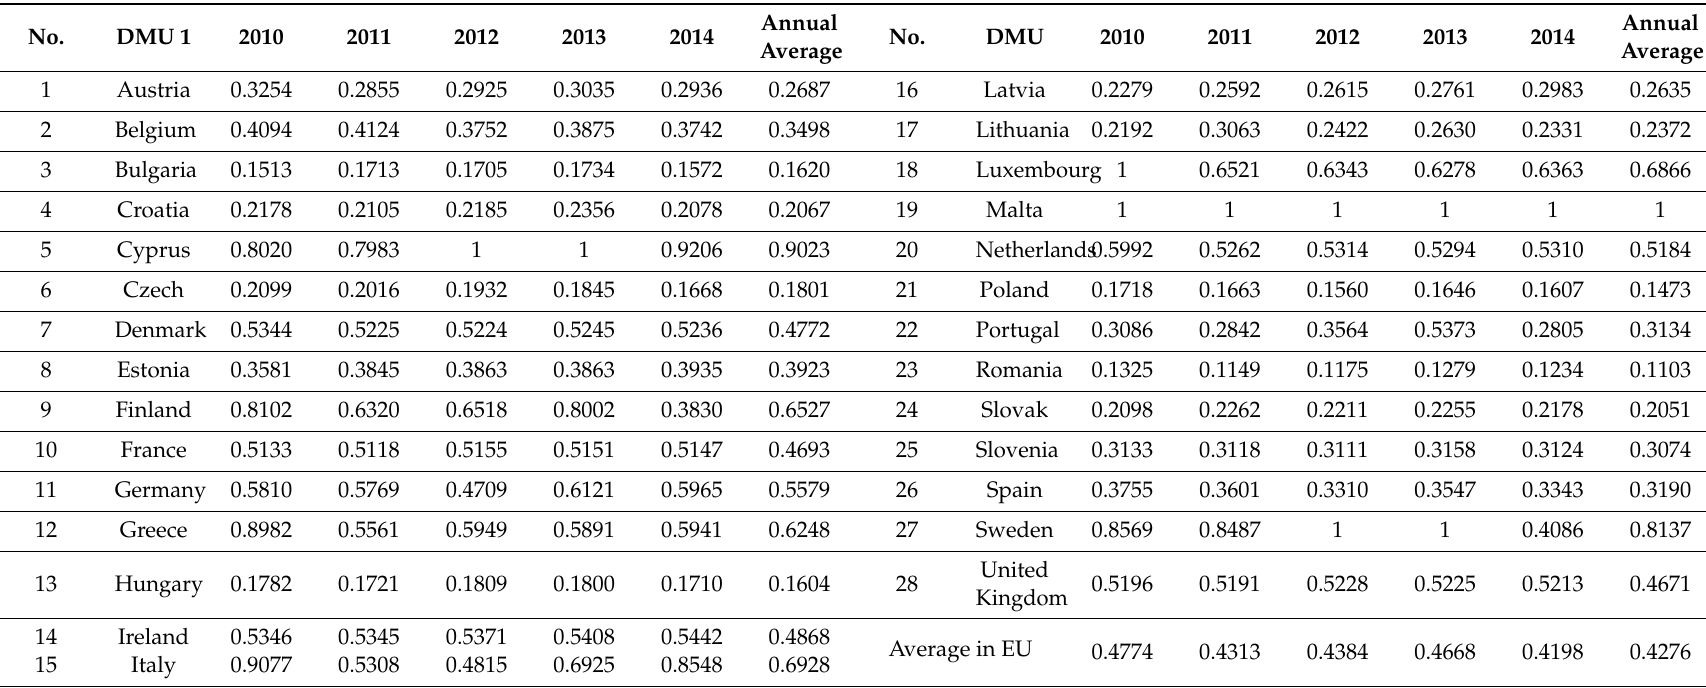
Table 5. Overall e ffi ciency by EU countries from 2010 to